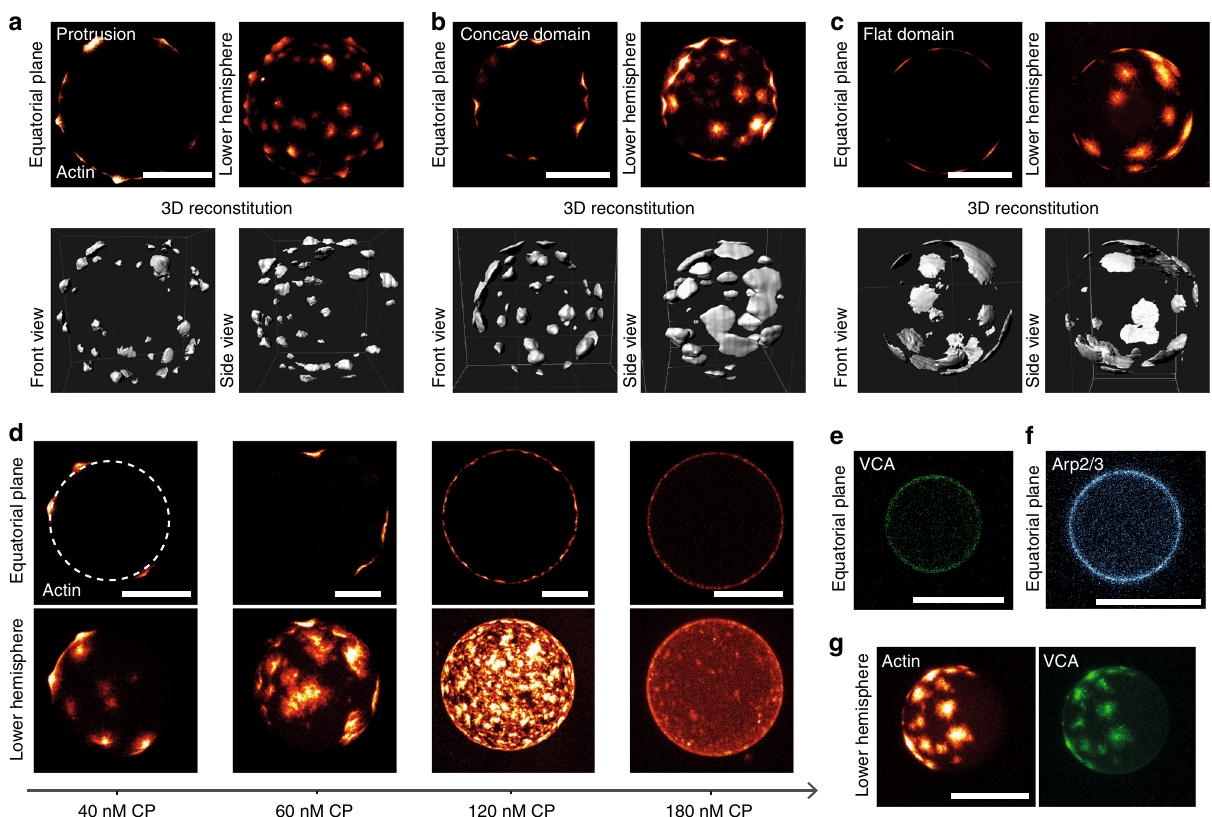
Fig. 2 Distinct domain morphologies appear at the membrane dependent on CP concentration. a-c The equatorial plane of the vesicle, a confocal z - projection of the lower vesicle ’ s hemisphere, the front and side view of digitally 3D reconstituted membrane localized actin domains are shown for the three different shape deformations: a Spatially con fi ned actin protrusions emerged at the membrane, which pushed the membrane forward and such induced a positive bending of the membrane. b Thick and laterally expanded actin patches grew at the membrane. The membrane sided surface was concave and imitated negative curvatures within the membrane. c Thin and laterally expanded actin domains grew along the membrane and did not induce any shape deformations of the membrane. d The observed actin shapes depended on CP concentration. Shown are exemplary confocal micrographs of Ni- NTA containing vesicles at different CP concentrations: actin protrusions (40 nM CP), concave actin domains (60 nM CP), concave actin cortices (120 nM CP) and undeformed cortices (180 nM CP). Top panels show the equatorial plane and bottom panels a z -stack projection of the lower hemisphere of the vesicles. The white-dashed line indicates the vesicle ’ s membrane. e , f Domain formation of actin was not induced by VCA or Arp2/3 complex clustering. e A total concentration of 0.3 µ M encapsulated VCA bound homogeneously to the Ni-NTA membrane in the absence of actin and any ABPs. A 25% of VCA was labelled with Atto 647N. f A total concentration of 0.3 µ M of Arp2/3 bound uniformly to the Ni-NTA vesicles in the presence of 0.3 µ M unlabelled VCA. A 35% of the Arp2/3 was labelled with Atto 647N. g VCA clustering induced by actin polymerization is shown. The full system containing 3 µ M actin, 0.3 µ M VCA, 0.3 µ M Arp2/3 complex, 60 nM CP and 13.5 µ M pro fi lin was encapsulated inside of Ni-NTA vesicles. A 25% of VCA was labelled with Atto 647N and 10% of actin was labelled with Atto 488. All scale bars are 20 µ